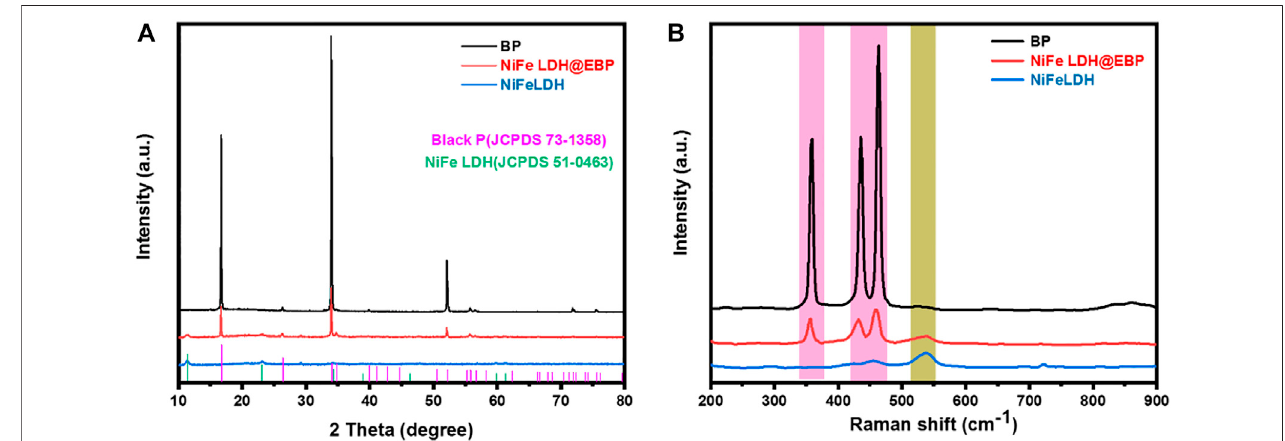
FIGURE 4 | (A) XPS survey spectra for EBP, NiFe-LDH, and NiFe LDH@EBP, high-resolution XPS spectra for (B) Fe 2p, (C) Ni 2p, and (D) O 1s of NiFe-LDH and NiFe LDH@EBP, and (E) P 2p core-level spectra of EBP and NiFe LDH@EBP.